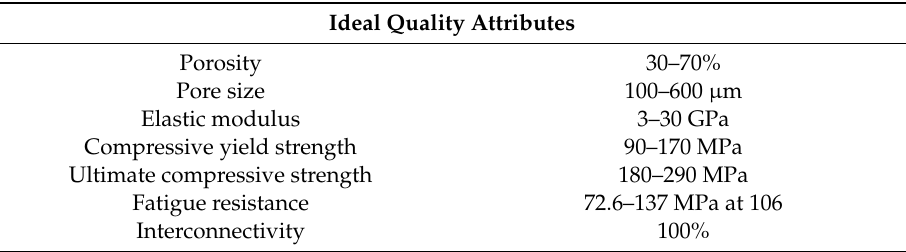
Table 7. Summary of Ideal Quality Attributes proposed in this